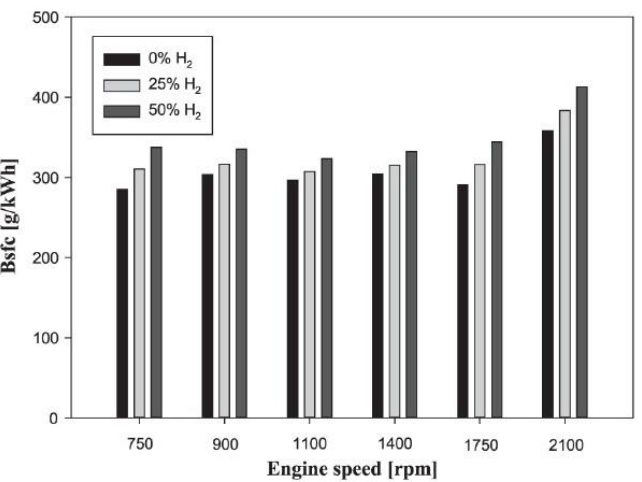
Figure 11. Brake thermal efficiency with different percentages of hydrogen in the SI engine